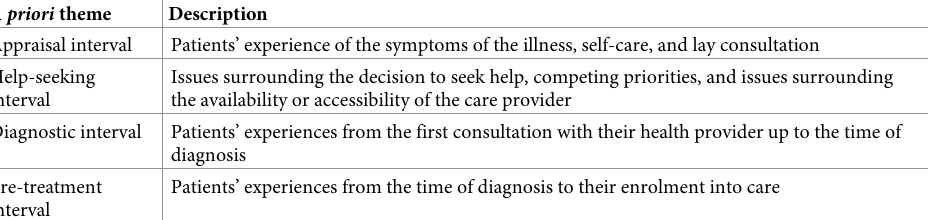
Table 2. A priori themes based on the four intervals from Walter’s model.